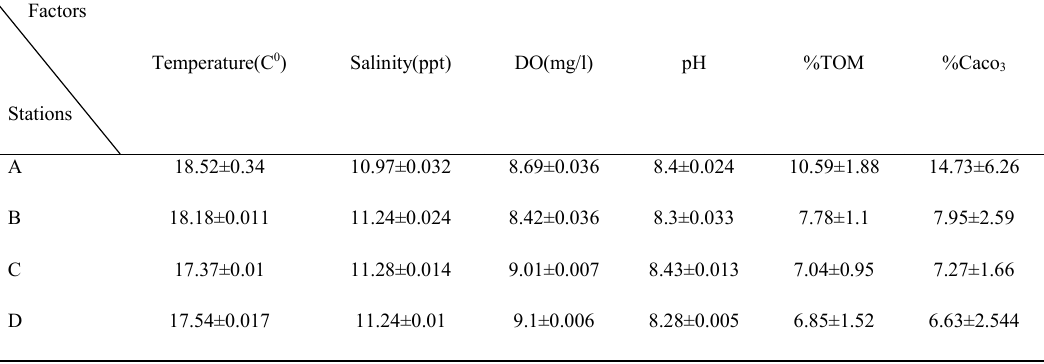
Table 4: The Mean of Temperature, Salinity, DO, pH, Total Organic Matter (TOM) and Caco3 in different Depths in the southern Caspian Sea from Behshahr to Ramsar (±SD). Factors